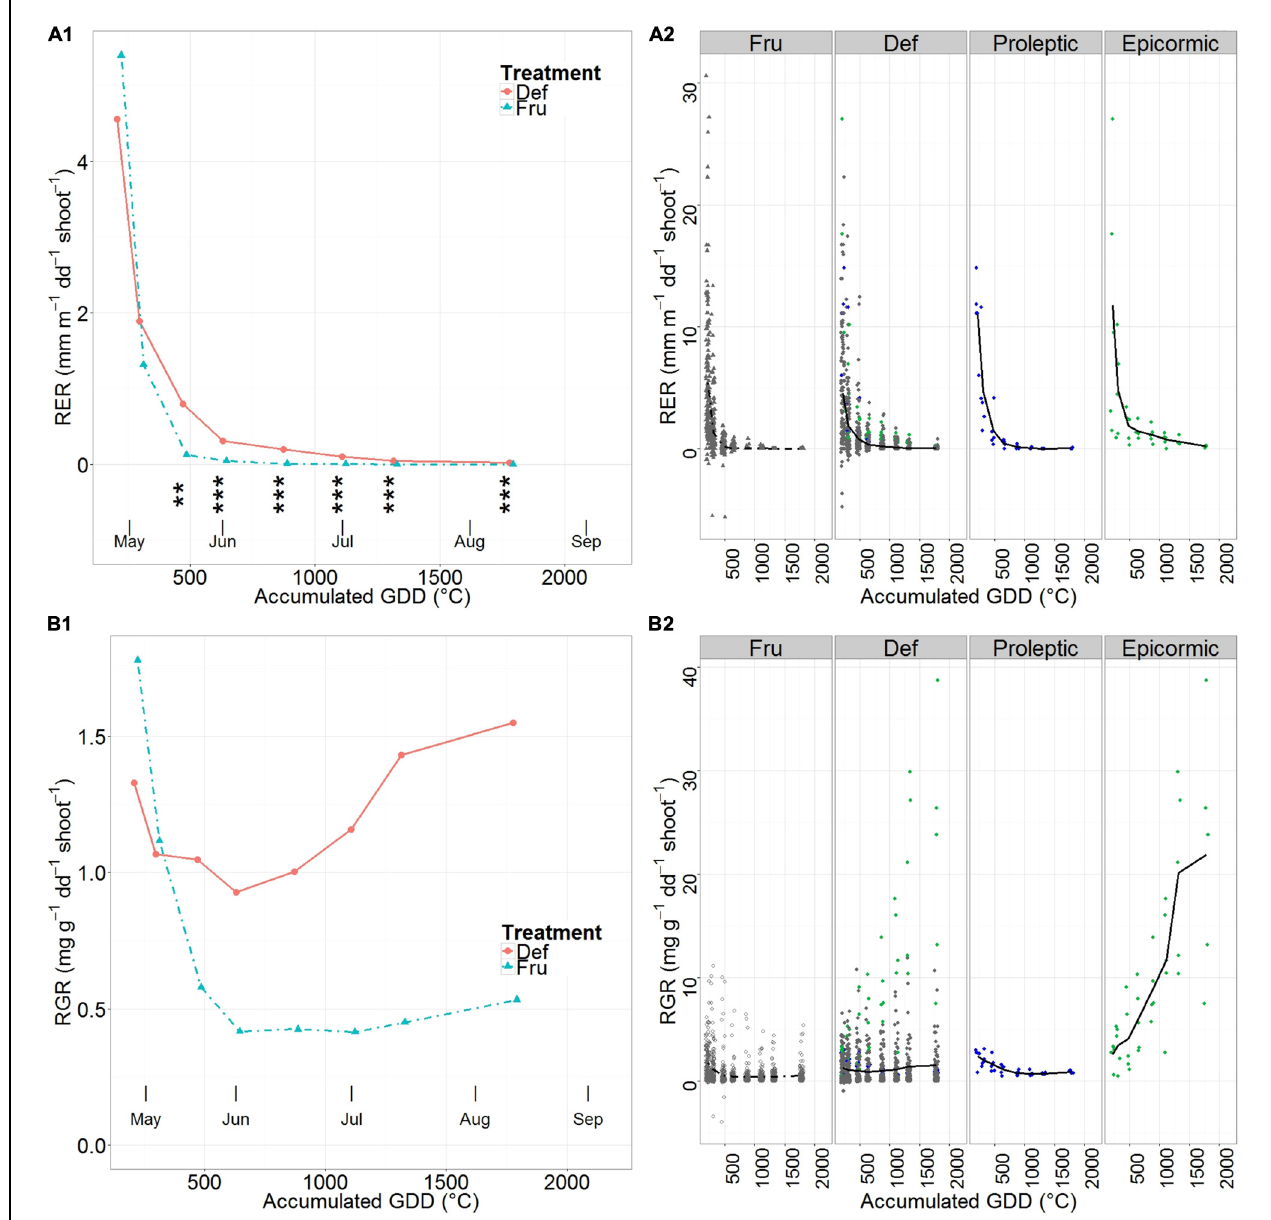
FIGURE 3 | Mean relative elongation rate (RER) (A) and relative growth rate (RGR) (B) of shoots on fruited (FRU) and defruited (DEF) trees vs. the accumulated growing degree days (GDD) after bloom. A synthetic summary of the mean response for the two treatments (FRU, dotdash; DEF, solid) is given (A1,B1) . In A1 stars indicate the level of significant differences between RER of DEF and FRU trees ( ∗∗ < = 0.01, ∗∗∗ < = 0.001). A comparison between FRU, DEF and the Max proleptic and epicormic shoots, extracted from the DEF population, is provided with individual observations in the background (A2,B2) . In (A2,B2) Max proleptic and epicormic shoots are colored respectively in green and